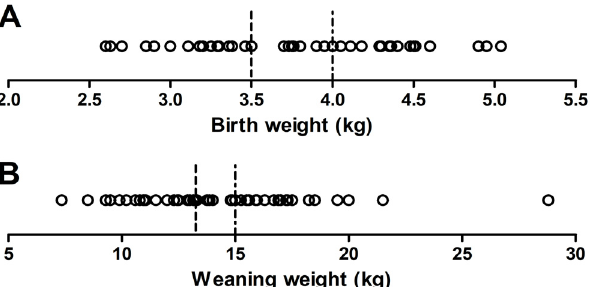
Figure 1. Distribution of lambs according to their birth weight ( A ) and weaning weight ( B ). The dashed lines indicate the thresholds for classification of animals into low and high groups.